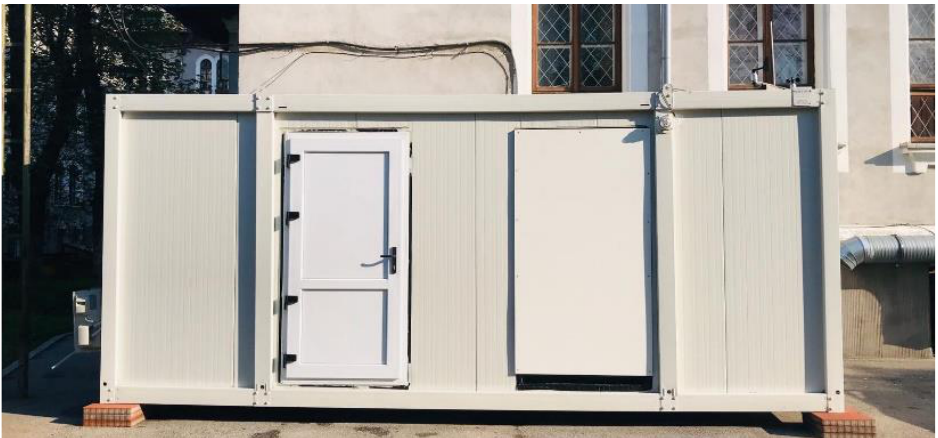
Figure 10. Experimental set-up: configuration without GTC.